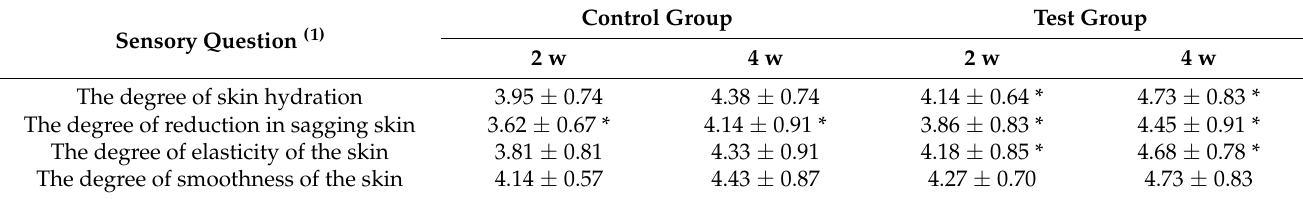
Table 3. The questionnaire scores after 2 and 4 weeks of using the collagen peptide buccal delivery film. Sensory Question (1)